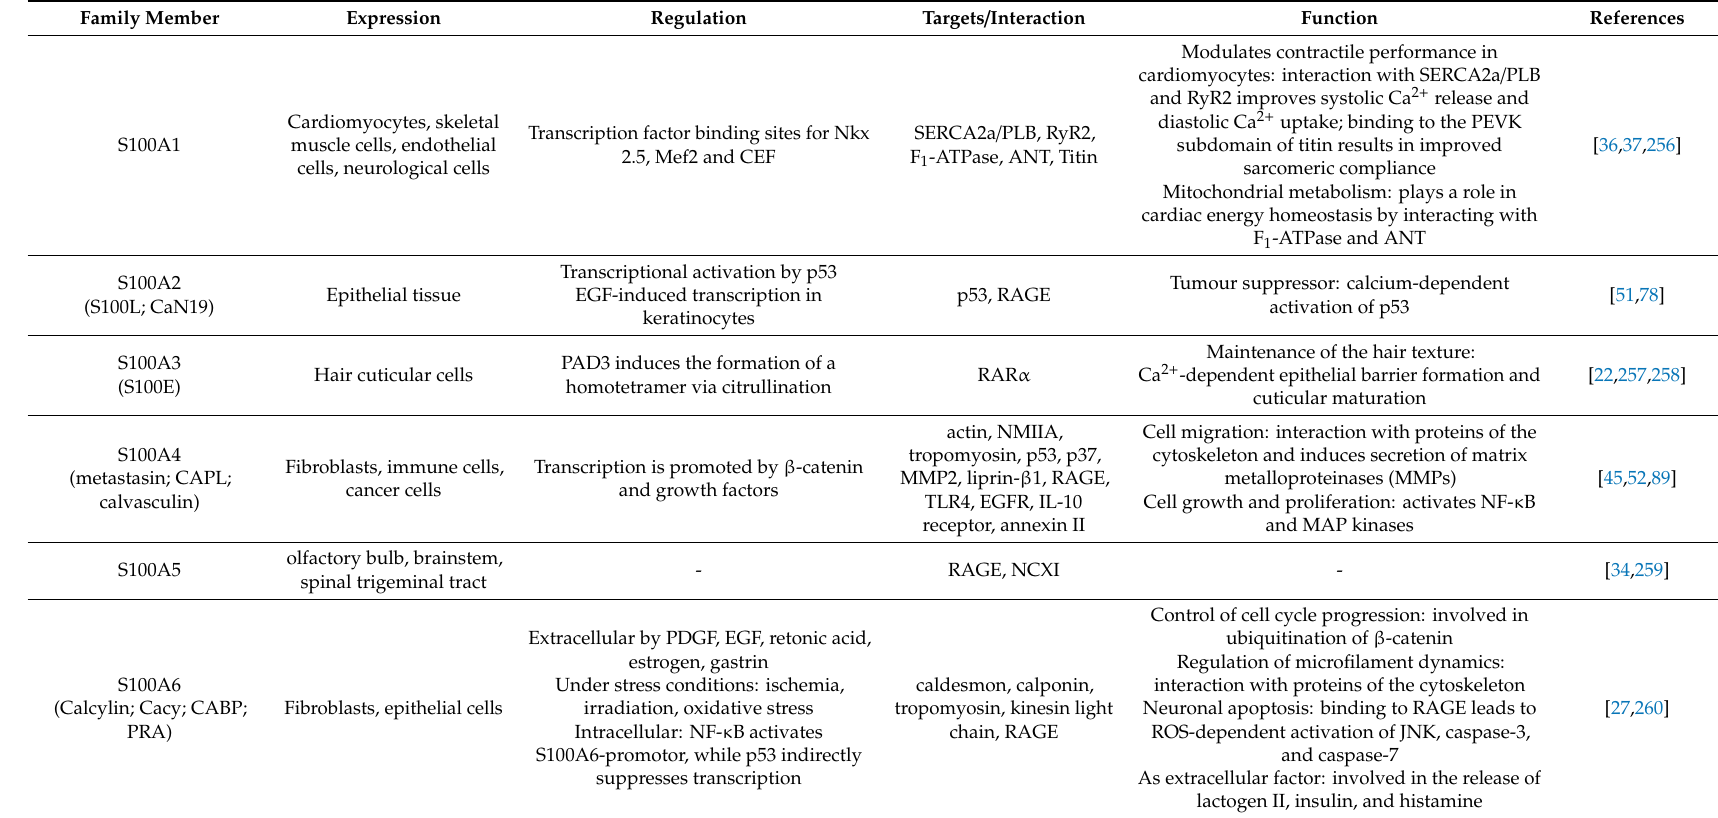
Table A1. Summary of the S100 family